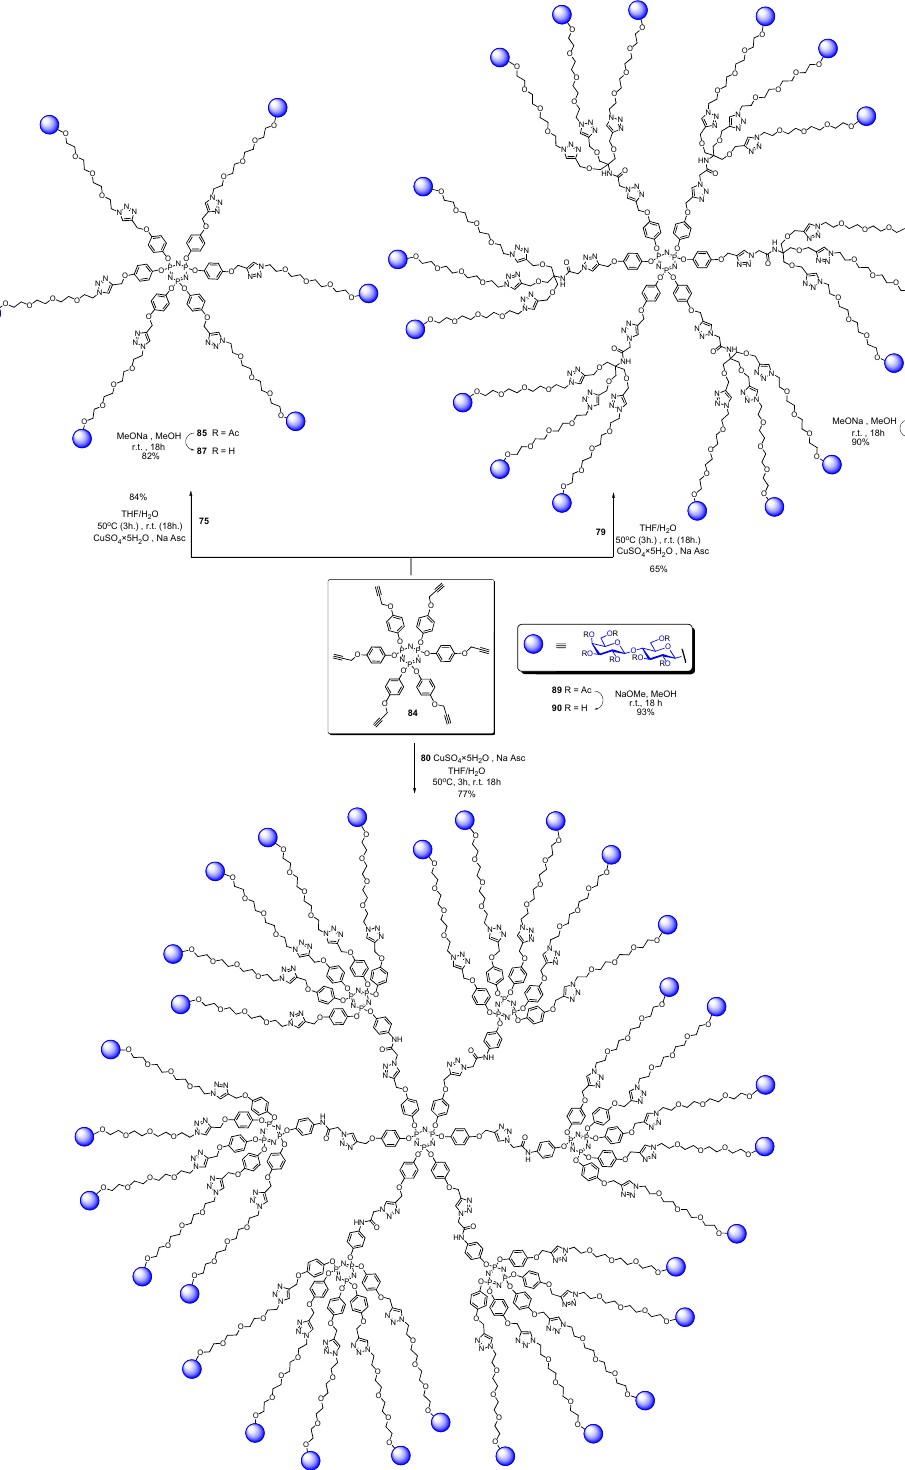
Scheme 19. Convergent synthesis of a globular glycodendrimer with six (6-mer, 87 ), eighteen (18-mer, 88 ), and thirty six (30-mer, 90 ) sugar headgroups.